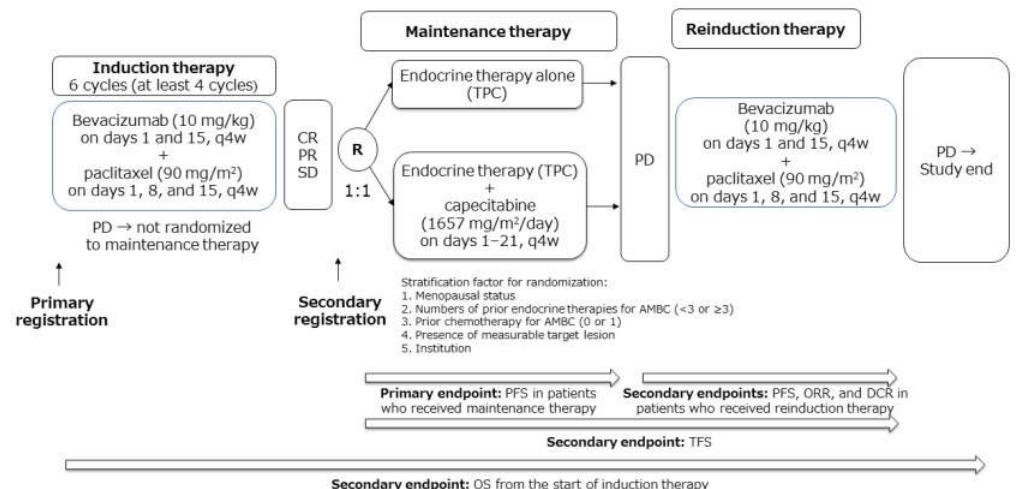
Figure 6. Study design. AMBC, advanced and metastatic breast cancer; DCR, disease control rate; CR, complete response; ORR, objective response rate; PD, progressive disease; PFS, progression-free survival; PR, partial response; R, randomization; SD, stable disease; TFS, time from randomization to failure of strategy; TPC, treatment of physician’s choice; q4w, every 4 weeks.